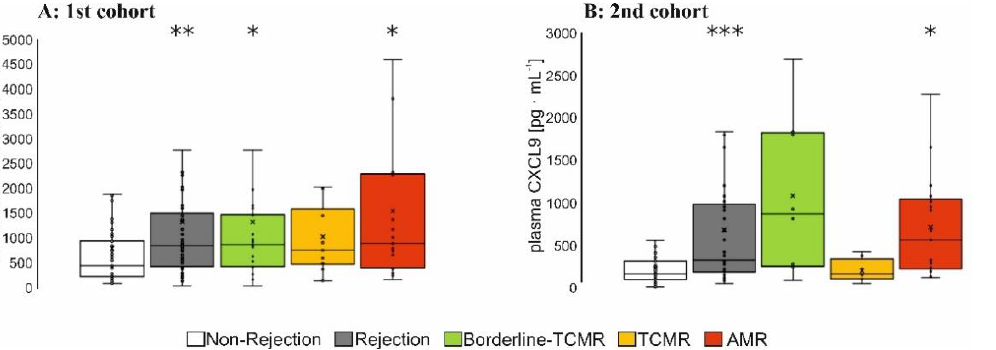
Figure 2. The 1st ( A ) and 2nd patient cohort ( B ): CXCL9 was determined using the Luminex-based multiplex protein array in the cryo-preserved EDTA-processed plasma samples of the kidney transplant recipients at the day of the biopsy. Boxplots show the median value, the mean and the standard error of the mean. Wilcoxon test revealed a statistical significance between groups with * p < 0.05; ** p < 0.01; *** p < 0.001 as indicated. TCMR = T-cell mediated rejection, AMR = antibody-mediated